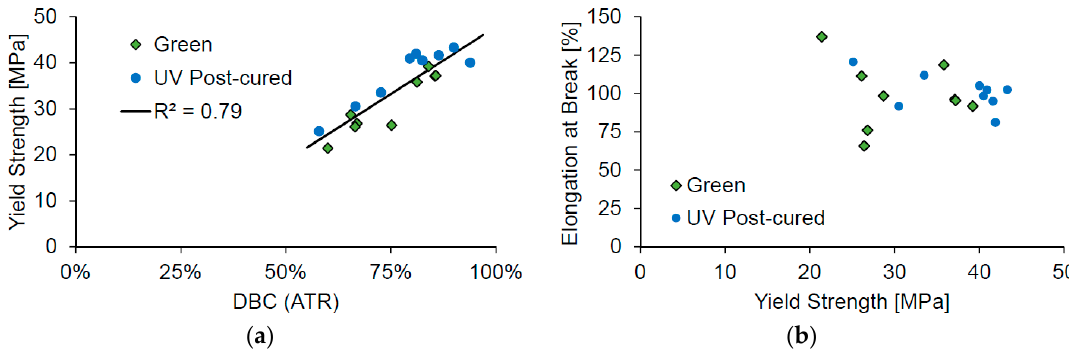
Figure 4. Comparing the measured yield strength to the corresponding double-bond conversion ( a ); and comparing the elongation at break to the yield strength ( b ).